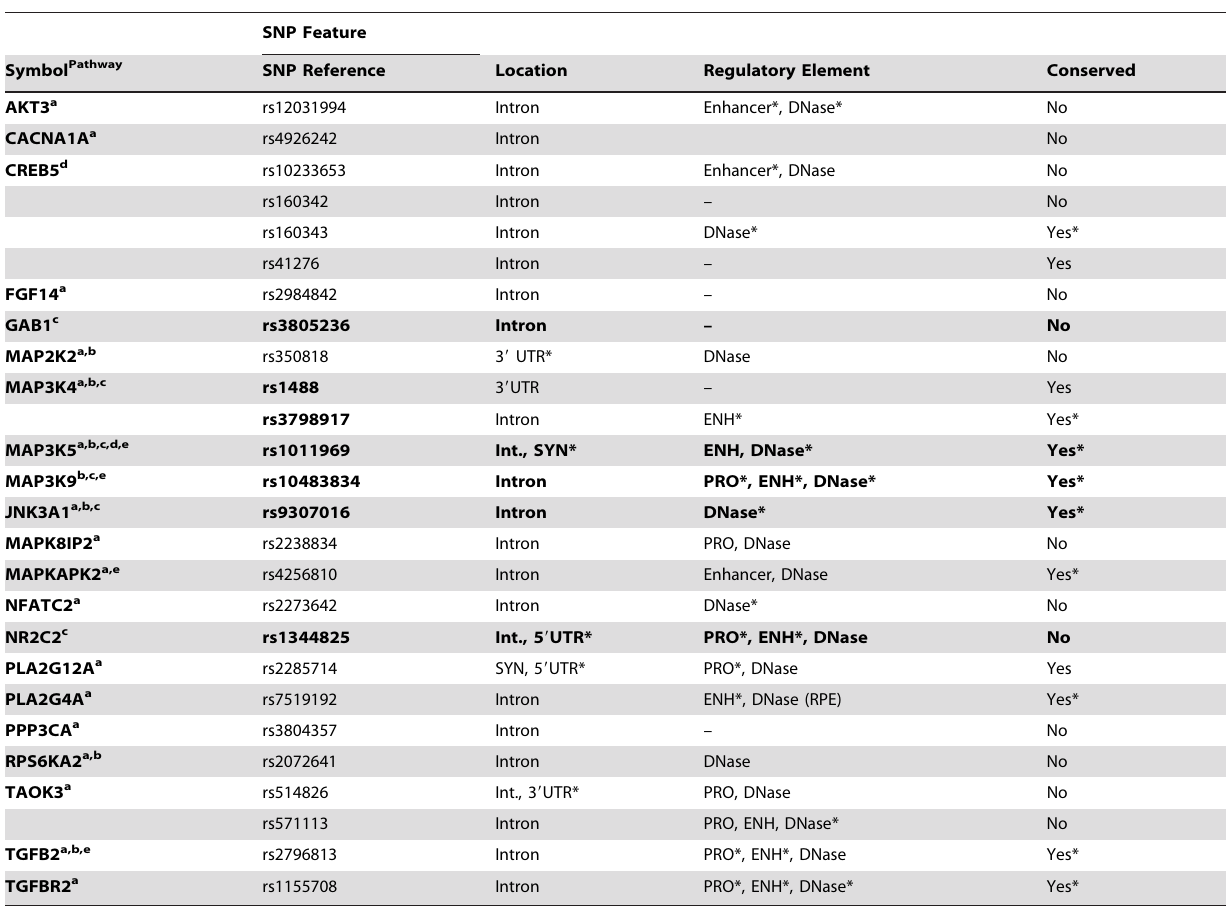
Table 3. Annotations of AAMD-associated sequence variants resident in MAPK